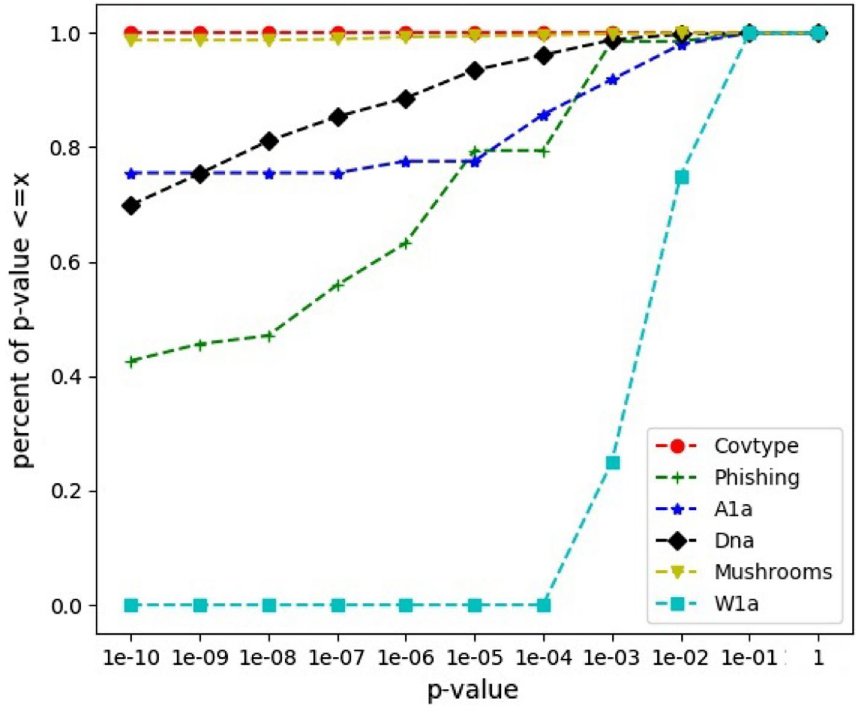
Fig. 15 The p -value distribution by